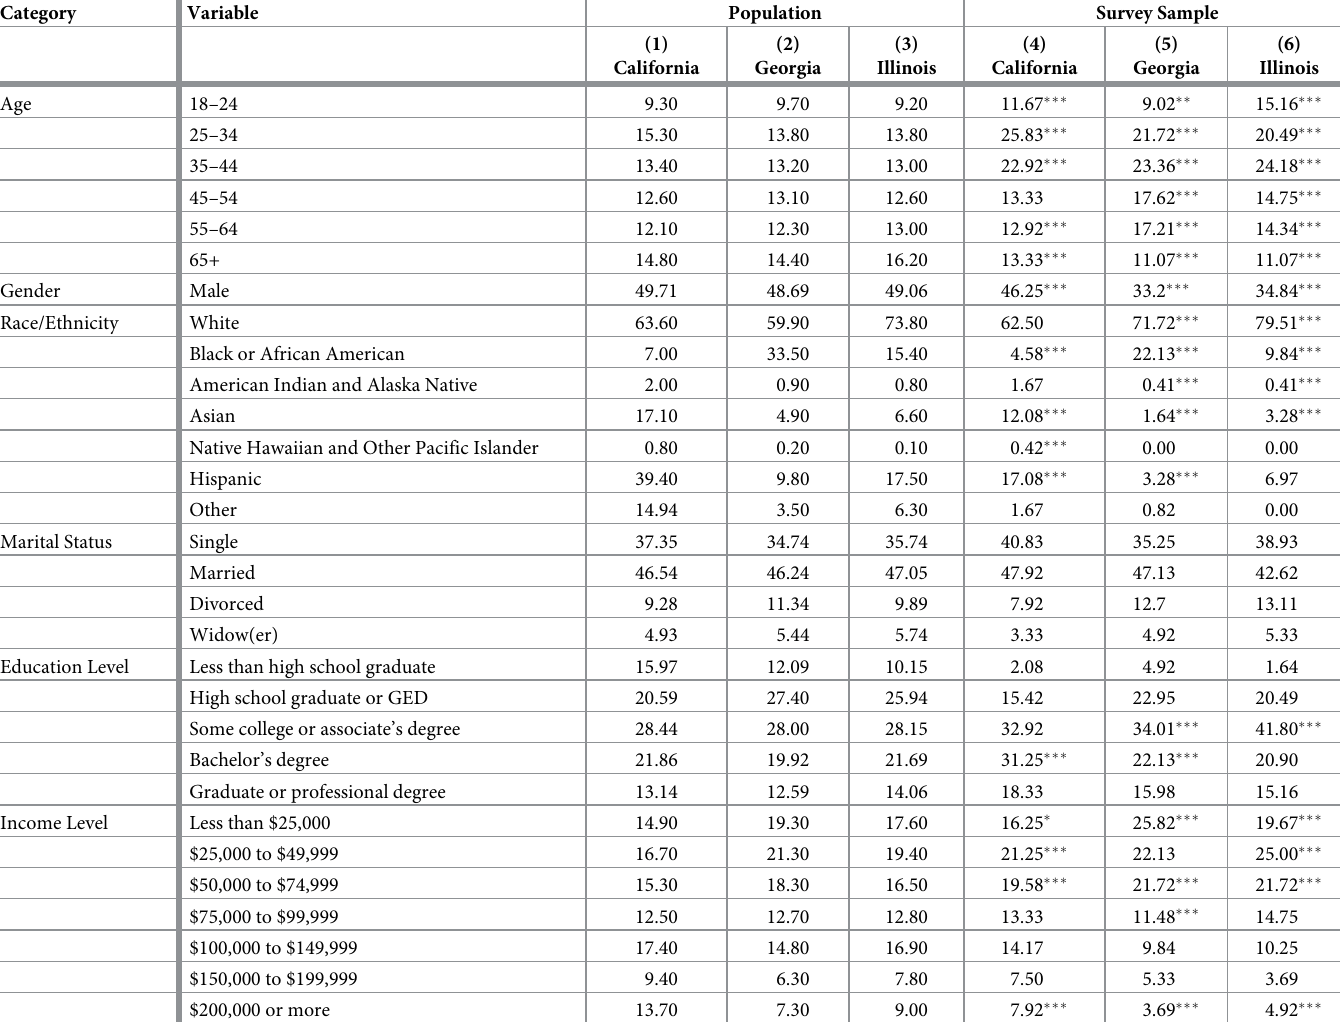
Table 1. Distribution of demographic characteristics of survey participants and the 2019 state-level